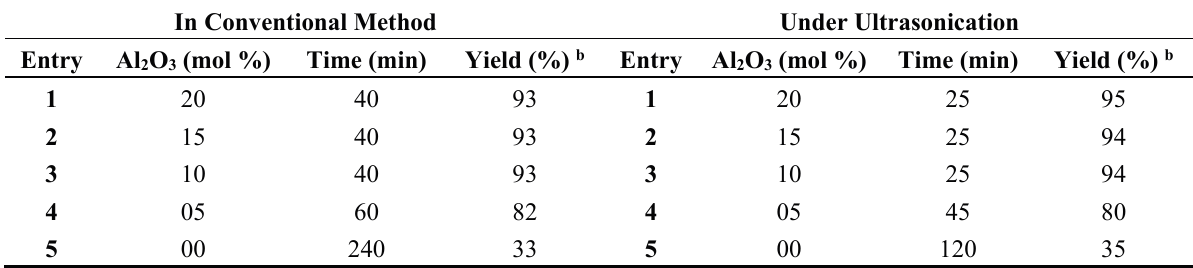
Table 1. Catalytic activity evaluation at 78 °C for synthesis of tetraaryl imidazole 8 in ethanol. In Conventional Method Under Ultrasonication